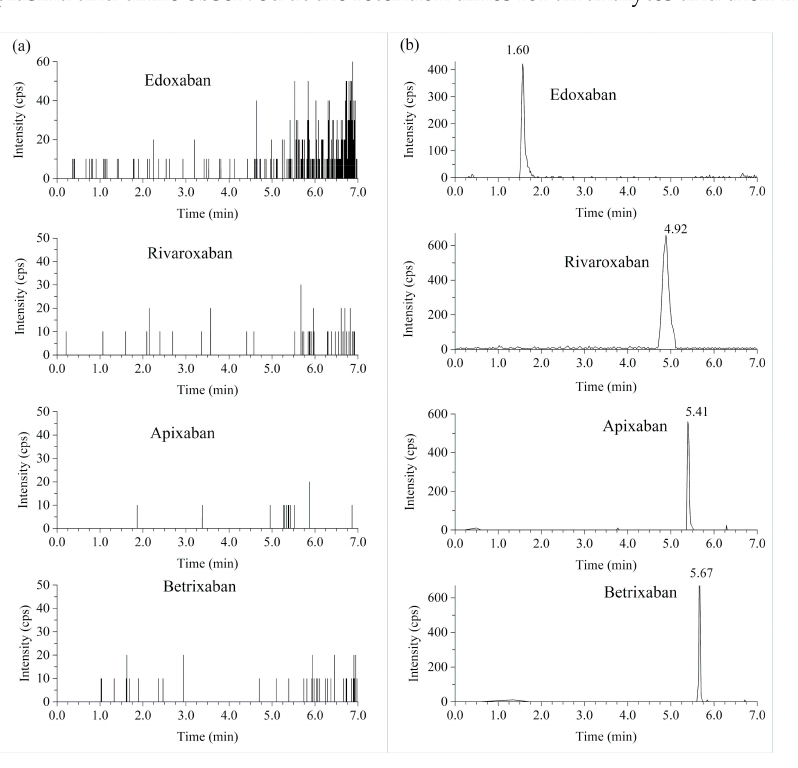
Figure 2. The UPLC/MS/MS chromatograms of extracted blank plasmas ( a ) and spiked with the lower limit of quantitation of 1 ng/mL in blank plasmas ( b ) of selected